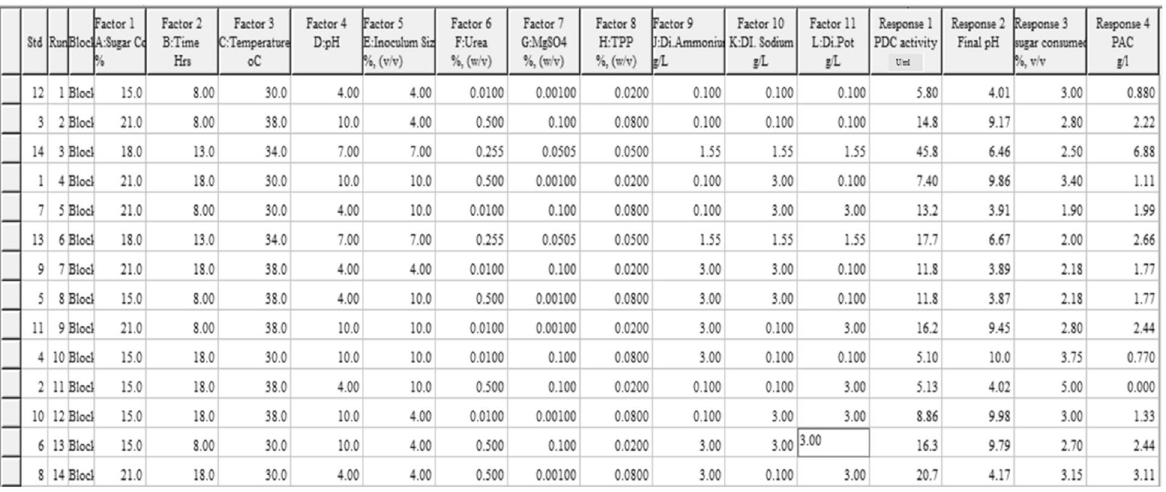
Table 1 Plackett-Burman model for linear regression analysis of all